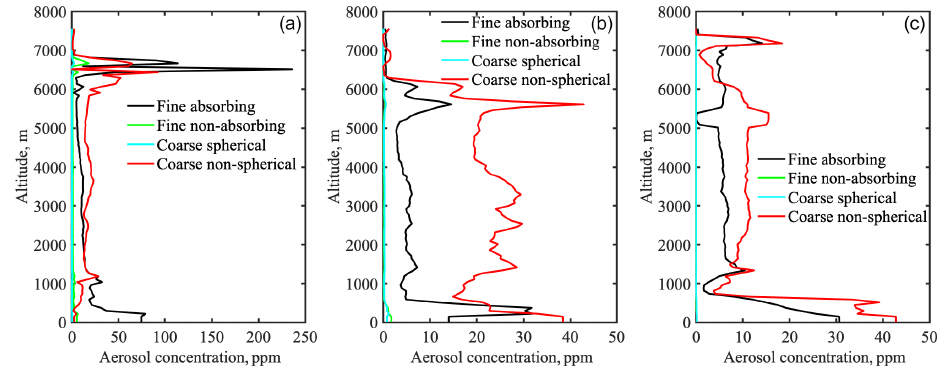
Figure 22. Aerosol vertical distributions retrieved from stand-alone COBALD observations performed on 5 August 2015, 11 August 2015 and 12 August 2016.